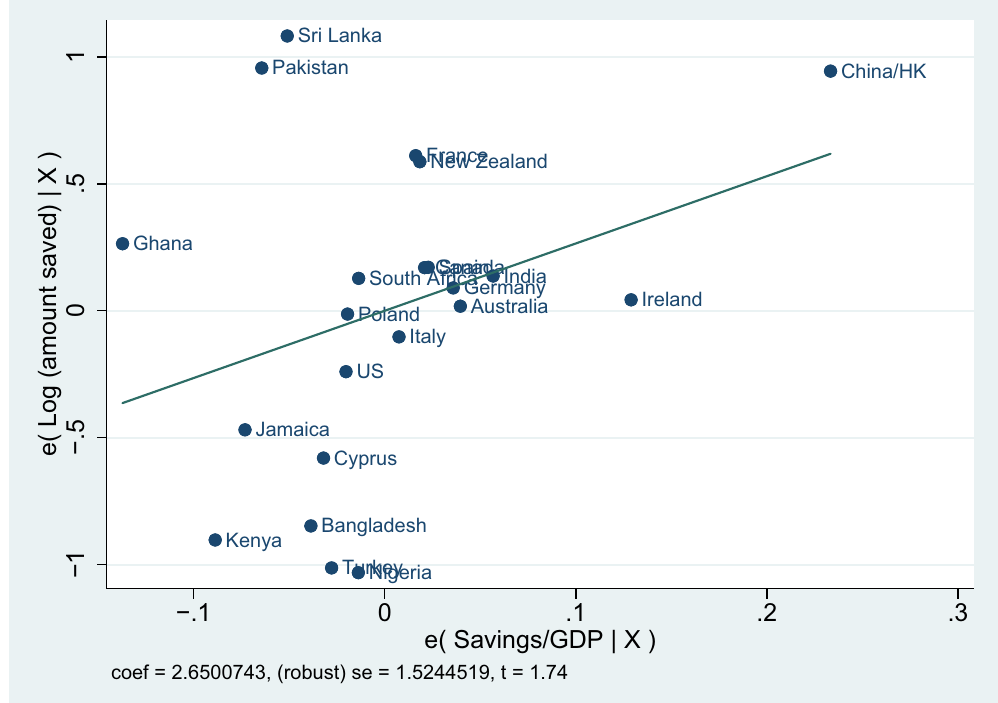
Fig 3. Partial correlation plot: Log (amount saved) for third generation immigrants. Log (amount saved) for third generation immigrants is the log of the self-reported monthly amount of saving divided by the net monthly household income. The saving rate in the countries of origin indicates the average gross domestic savings over GDP from 1990–2010.